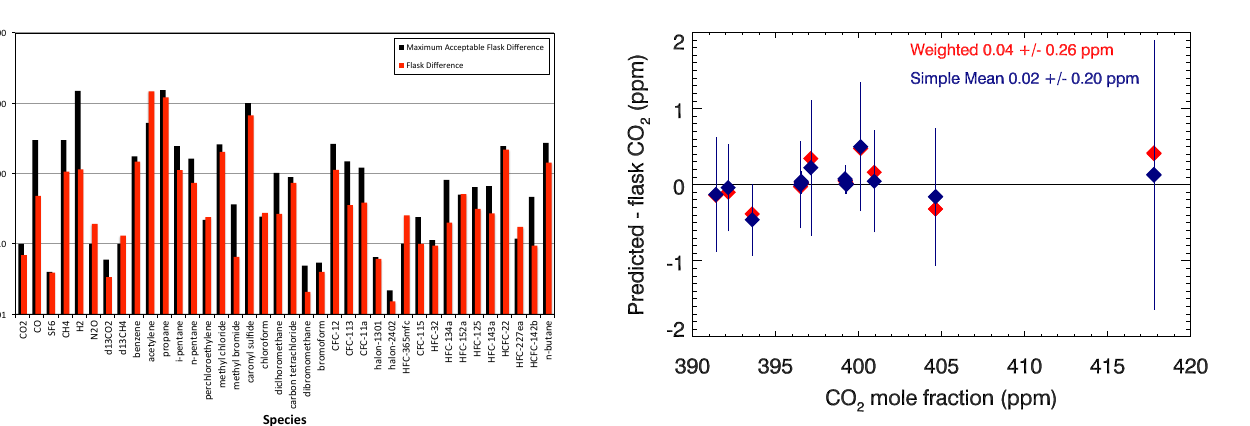
Fig. 5. Mean flask pair differences, typically averaged over 12 flask pairs. Measured mean pair differences for each species are shown in red, and the acceptable maximum pair difference is shown in black. Vertical axis uses a log scale for clarity, units vary by species. CO 2 is reported in ppm, CO, CH 4 , N 2 O and H 2 are in ppb, δ 13 CO 2 and δ 13 CH 4 are in ‰, all other species are in reported in ppt.